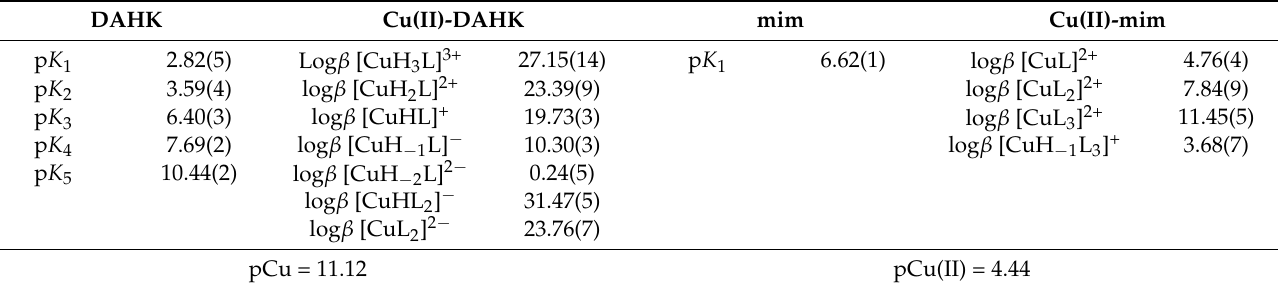
C, I = 0.10 M (KCl)}. (cid:35)